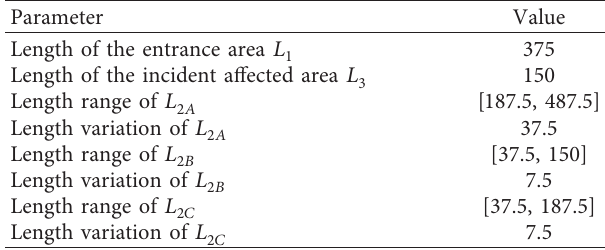
Figure 6: The relationship of automated vehicle penetration to the road